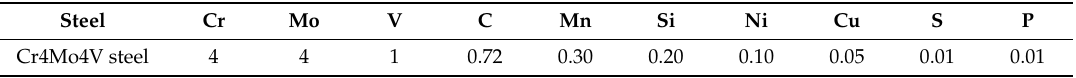
Table 1. Chemical composition of the Cr4Mo4V steel